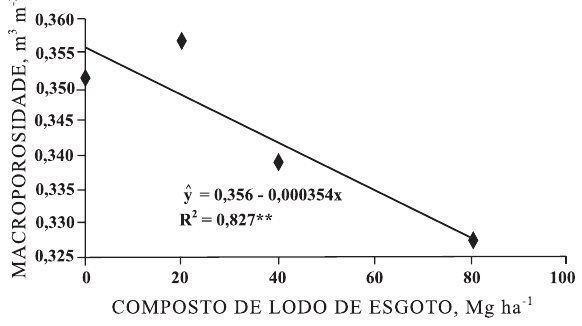
Figura 3. Médias da microposidade do solo, na camada de 0,20–0,40 m, e análise da regressão em função das diferentes doses de composto de lodo de esgoto (** = significativo a 1